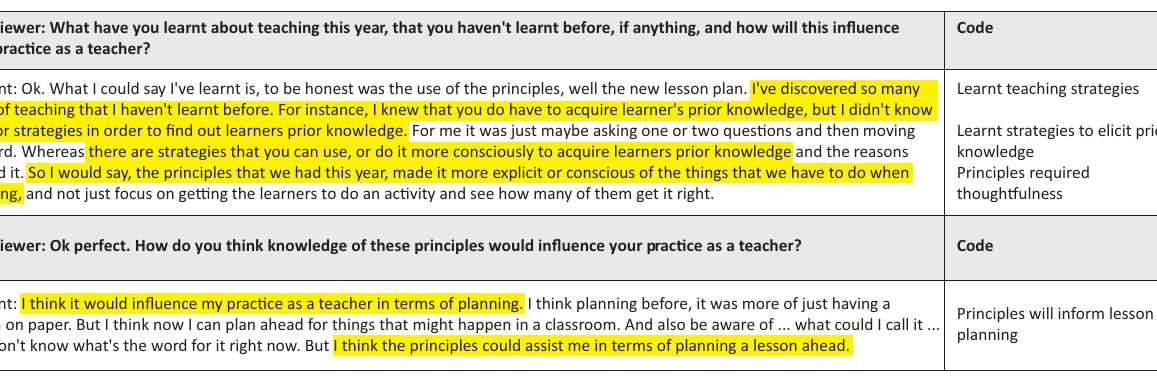
FIGURE 1: Example of how transcripts were coded